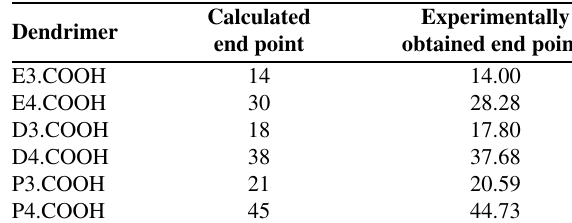
Figure 3. Absorption spectra (at 680 nm) of (a) E4.COOH dendri- mer (0.321 mM) solution titrated with Cu 2+ (80.14 mM), (b) D4.COOH dendrimer (0.268 mM) solution titrated with Cu 2+ (80.50 mM), (c) P4.COOH dendrimer (0.200 mM) solution titrated with Cu 2+ (79.86 mM).